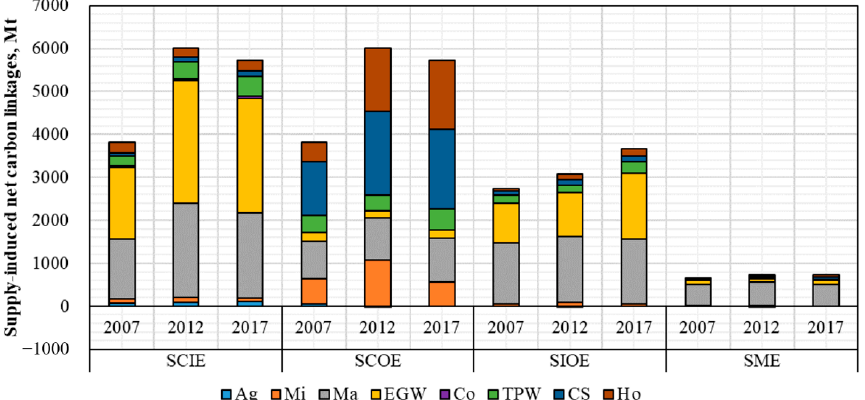
Figure 3. Supply-induced net carbon linkages of China